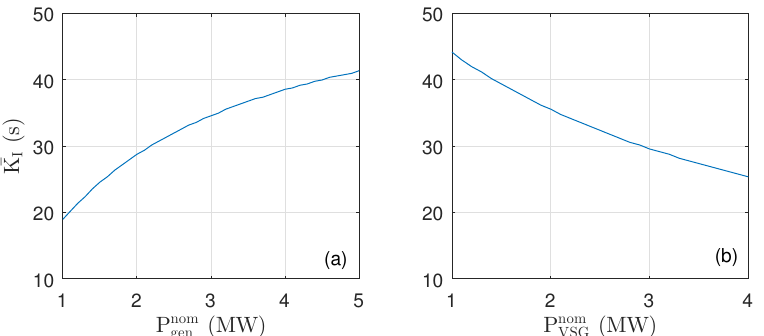
Figure 9. Maximum virtual inertia gain limit for satisfying damping criteria as function of nominal power of the generator in ( a ) and VSG in ( b ) ( f c = 40 Hz).